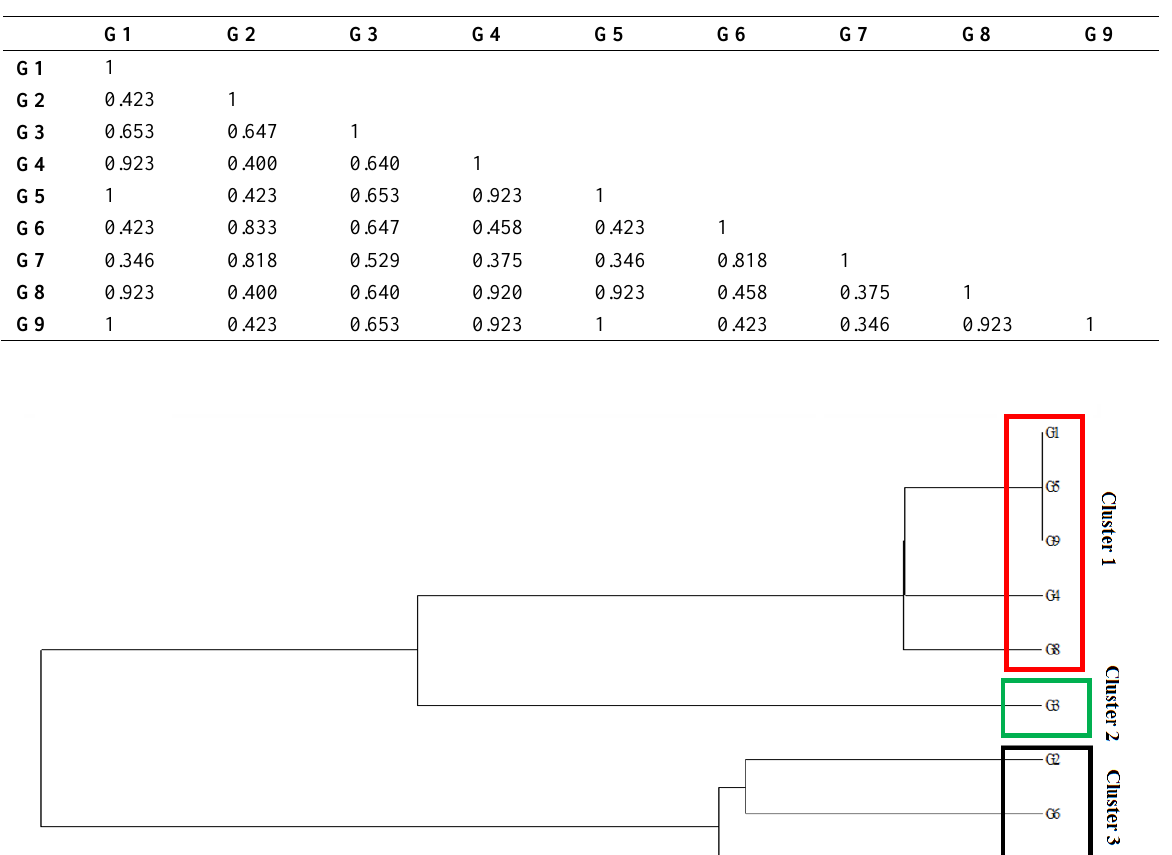
Table 5. Jaccard similarity coefficients between genotypes of Mentha .